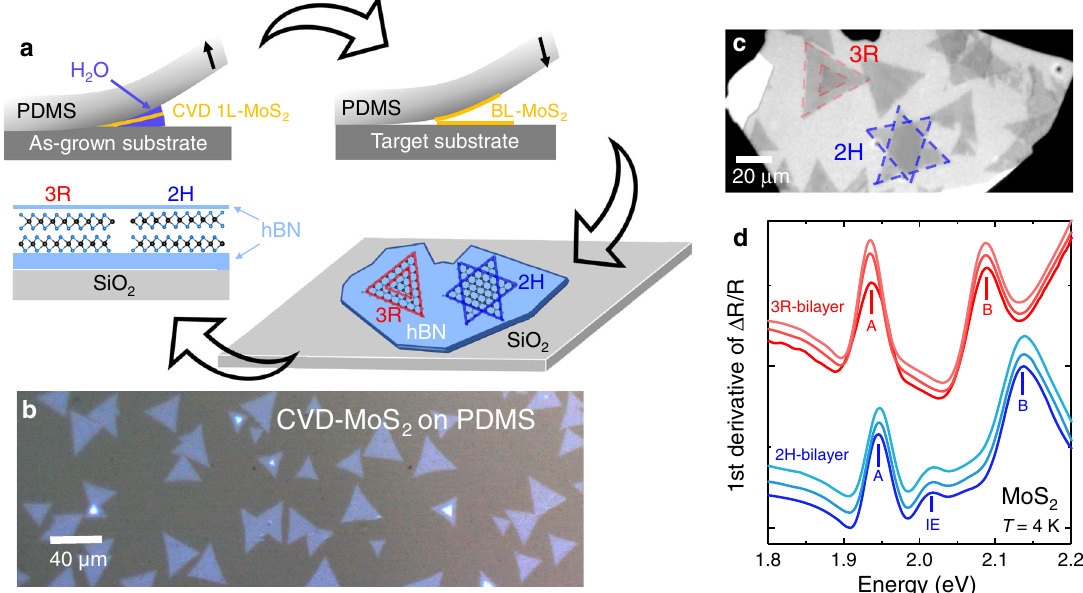
Fig. 2 Arti fi cial stacking of CVD monolayers into bilayers. a Schematic of sample pick-up, bilayer assembly, and encapsulation for optics. b Optical micrograph of CVD-grown MoS 2 monolayers and a few homobilayers, transferred to the PDMS stamp following water-assisted pick-up 32 from the growth substrate. c Arti fi cially-assembled 3R and 2H MoS 2 homobilayers, fabricated by an all-dry deterministic transfer process. d First derivative of re fl ectivity spectra collected from three different areas of the arti fi cially stacked 3R (red) and 2H (blue) MoS 2 homobilayers, shown in ( c ). Spectra have been shifted for